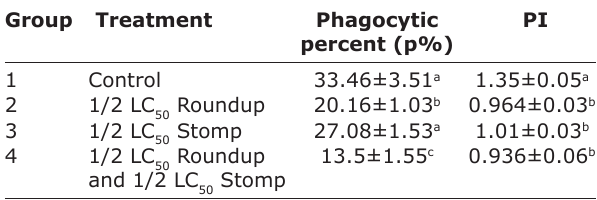
Table-1: Changes in phagocytic percent (p%) and PI in C. gariepinus exposed to Roundup, Stomp, and both after 15 days of exposure (mean±SE)